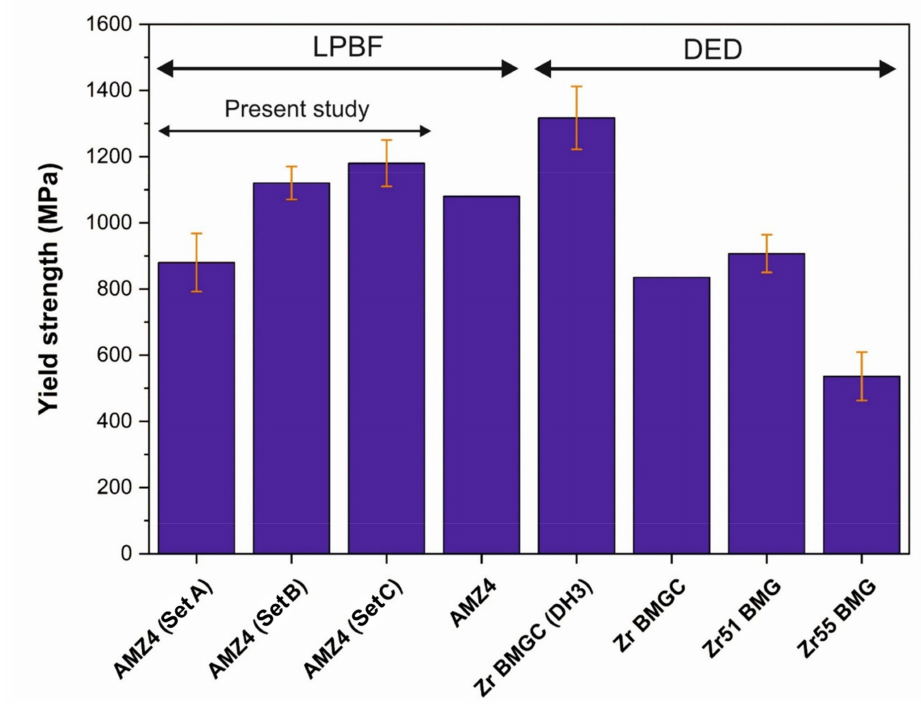
Figure 7. Comparison of tensile yield strengths in the present study with a LPBF man- ufactured AMZ4 [33], and with DH3 (Zr 39.6 Ti 33.9 Nb 7.6 Cu 6.4 Be 12.5 ) [37], Zr BMG compos- ite (Zr 39.6 Ti 33.9 Nb 7.6 Cu 6.4 Be 12.5 ) [34], Zr51 BMG (Zr 51 Ti 5 Ni 10 Cu 25 Al 9 ) [35], and Zr55 BMG (Zr 55 Cu 30 Al 10 Ni 5 ) [36] fabricated via direct energy deposition